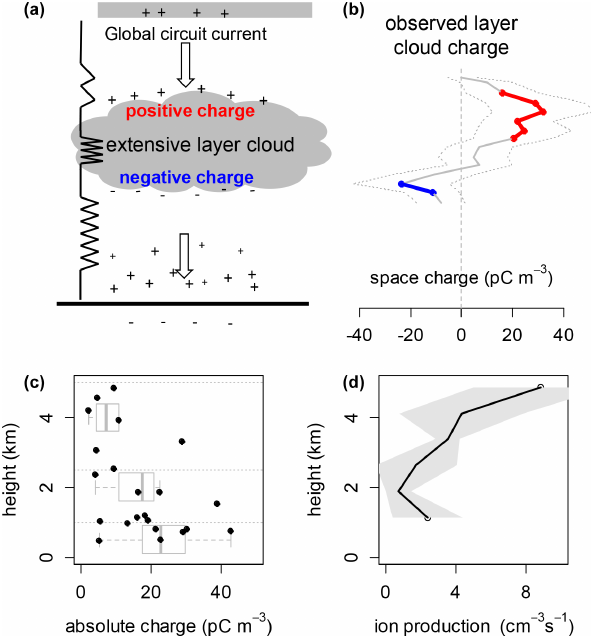
Figure 17. Summary of radiosonde findings concerning extensive layer clouds. (a) Expected vertical charge structure around a layer cloud, arising from vertical current flow through a step change in air conductivity at the horizontal cloud boundaries and (b) observed charge structure from soundings in both hemispheres. (c) Absolute charge observed on layer clouds and (d) variation in ion production rate with height, averaged from the same sites as the cloud charge measurements. (Adapted from Nicoll and Harrison,